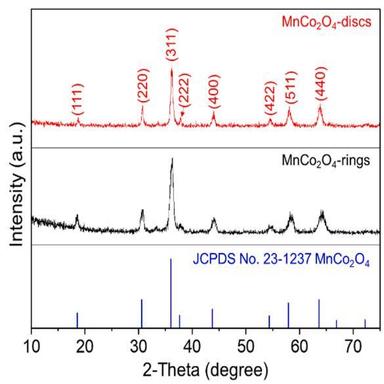
XRD patterns of MnCo2O4-discs prepared at 110 ◦C and MnCo2O4-rings obtained at 185 ◦C, and a post-annealing treatment at 450 ◦C for 4 h in air was performed for both samples.